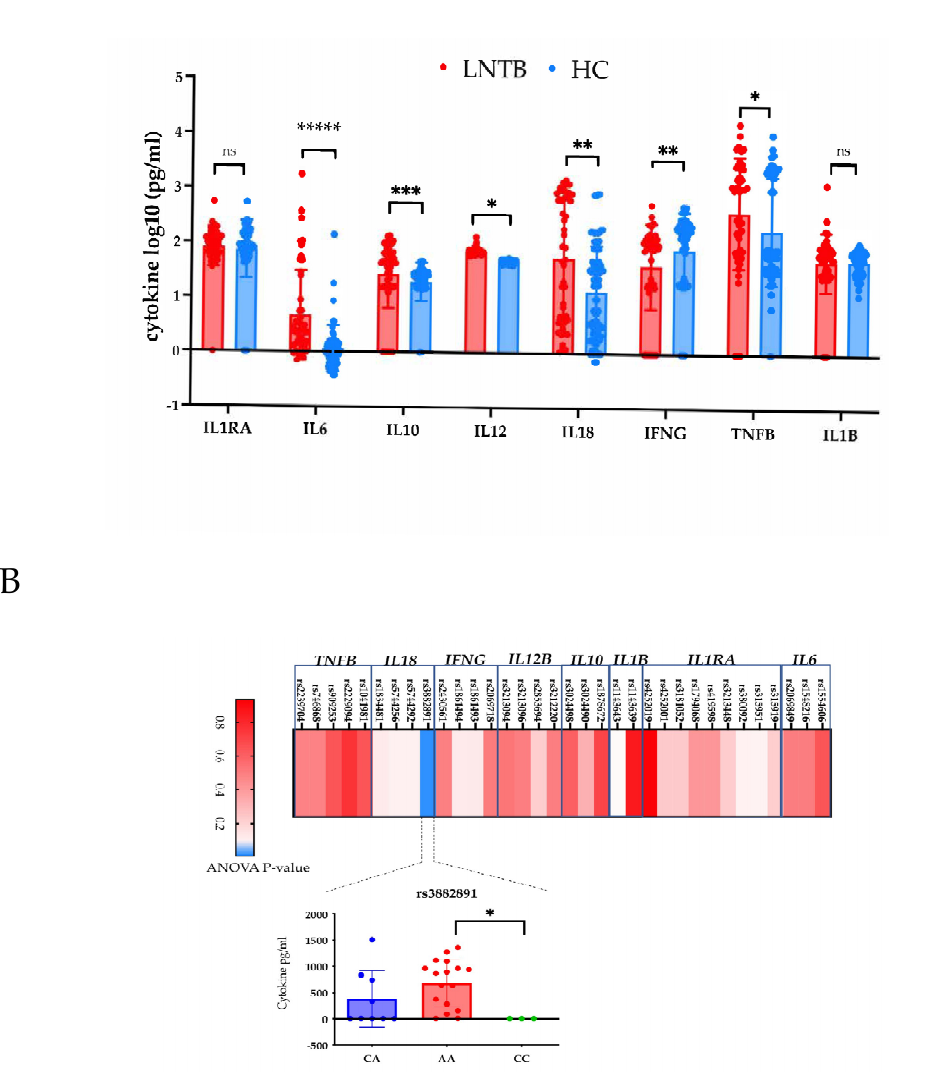
Figure 2. Cytokine levels have limited correlation with genotypes in LNTB. ( A ) Increased cytokine levels in LNTB (n = 50, red) vs HC (n = 84, Blue). The groups were compared using a multiple Mann-Whitney test. ***** p < 0.00001, *** p < 0.001, ** p < 0.01, * p < 0.05, ( B ) Heatmap of overall ANOVA p -Values of 34 SNPs in the cytokine genes with the corresponding cytokine levels. Shades of Red depict non-significant p -values and shades of blue significant p -value. Only significant variant, IL18 at rs3882891 is shown with the genotypes with their respective levels, where AA genotype individuals are highest IL18 producers and compared to CA and CC ( p < 0.05)